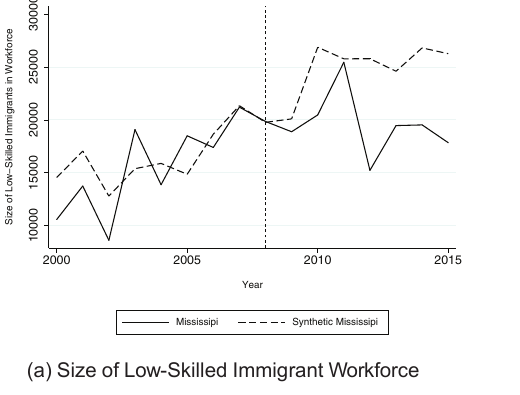
Figure A5 Mississippi universal e-verify and size of low-skilled immigrant workforce